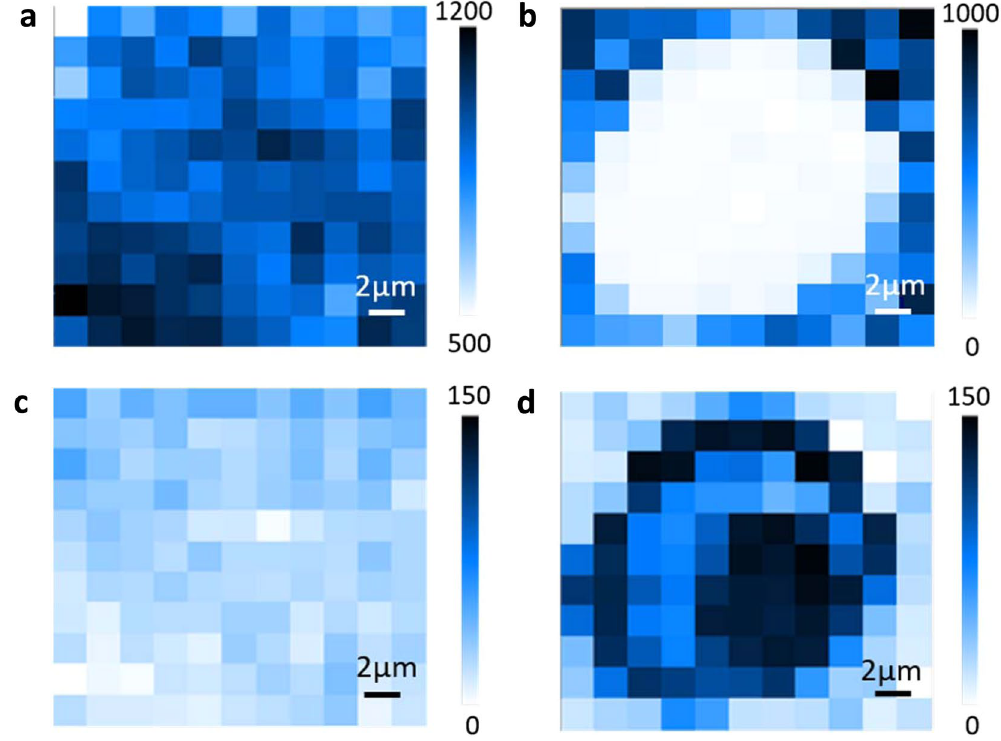
Figure 5. Raman mapping images of WS 2 film ( a ) before and ( b ) after laser treatment at wavelength of 356 cm − 1 (representing the existence of WS 2 ); ( c ) before and ( d ) after laser treatment at wavelength of 710 cm − 1 (representing the existence of WO 3 ). Darker region means stronger